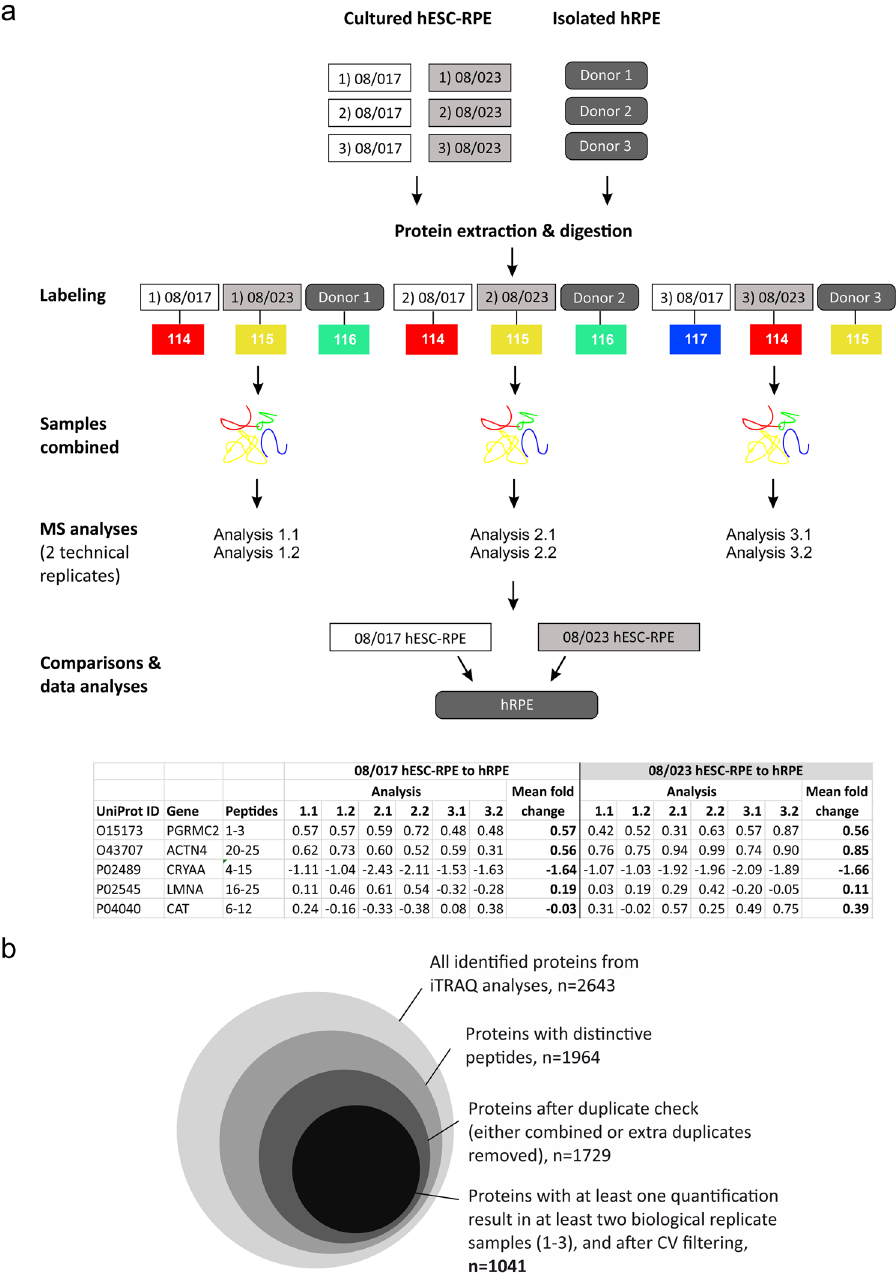
Figure 1. Workflow of the study. ( a ) Study design of the iTRAQ proteomics. Human ESC-RPE samples from three independent differentiation experiments consisted of three replicate samples each. Human RPE samples were collected from three cadaveric donor eyes. Total protein was extracted and digested with trypsin. Peptides were labeled with iTRAQ 4-plex labels 114–117 shown in colors, and analyzed as technical duplicates with Nano-RPLC- Triple TOF instrumentation. For final data analyses the results were pooled togerther from all six LC-MS/MS analyses separately for 08/017 nad 08/023 hESC-RPE. ( b ) A Venn diagram illustrating the data processing before data analyses from total number of protein hits to 1041 proteins accepted for final data